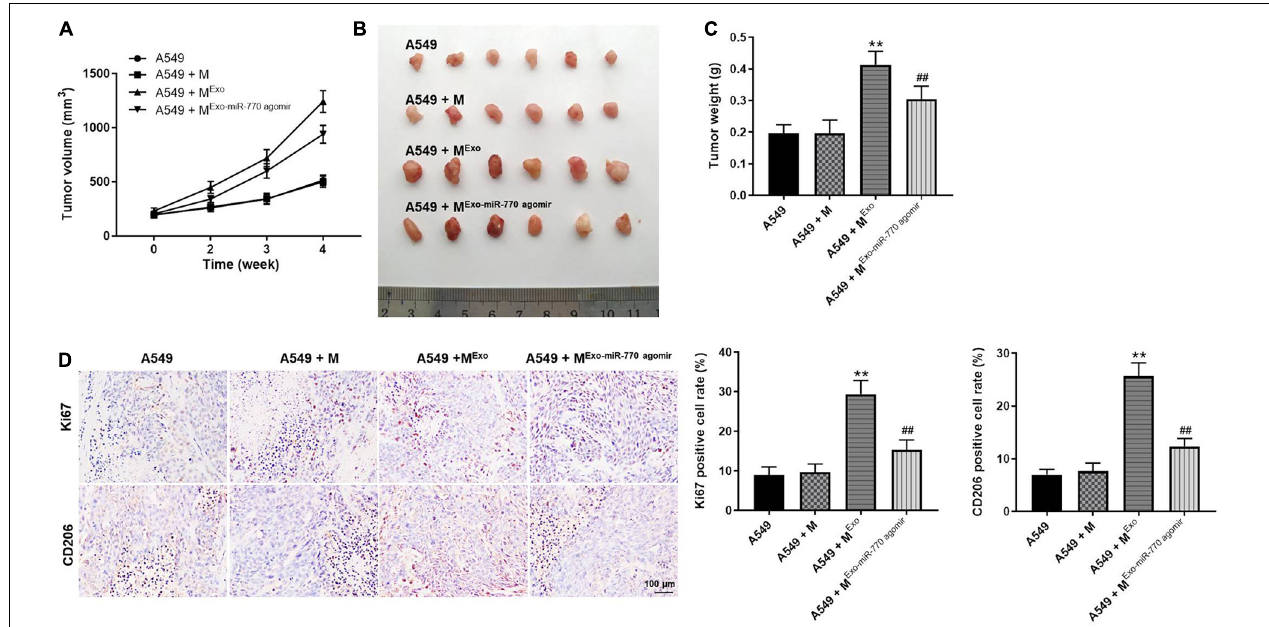
FIGURE 8 | Exosomal miR-770 significantly inhibited the tumor growth of NSCLC in vivo via suppressing the M2 polarization of macrophages. (A) The tumor volume of mice was measured every week for four weeks. (B) The tumor tissues of mice were pictured. (C) Tumor weights of mice were measured. (D) The expressions of Ki67 and CD206 in tissues of mice were detected by IHC staining. The relative expressions were calculated. N = 6; ** P < 0.01 compared to A549 cells, ## P < 0.01 compared to A549 + M Exo